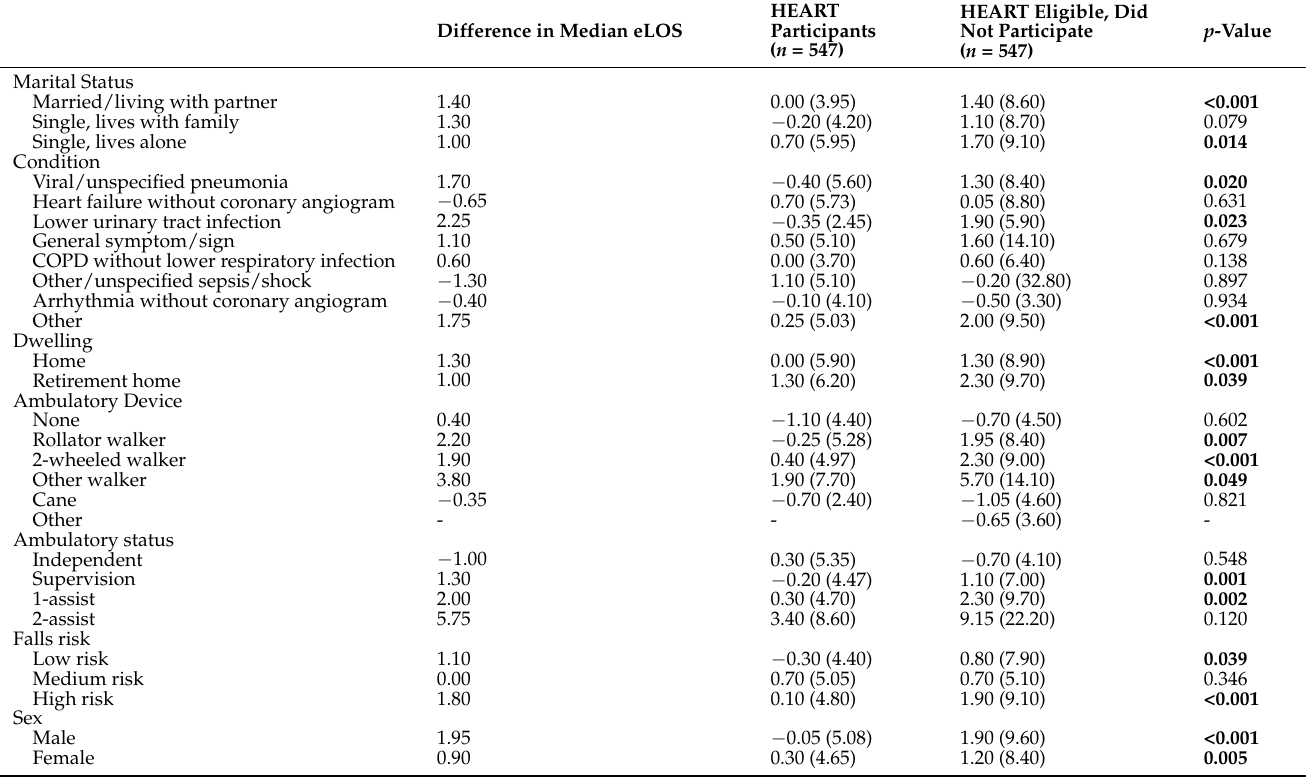
Table 2. Excess length of stay in HEART and non-HEART participants based on predictor variables, median (IQR).